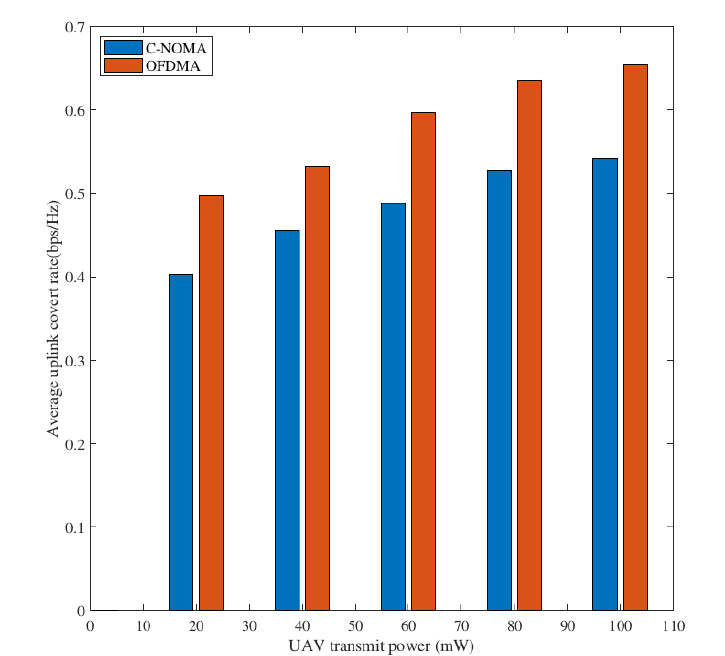
Figure 8. The average uplink covert rates for C-NOMA and